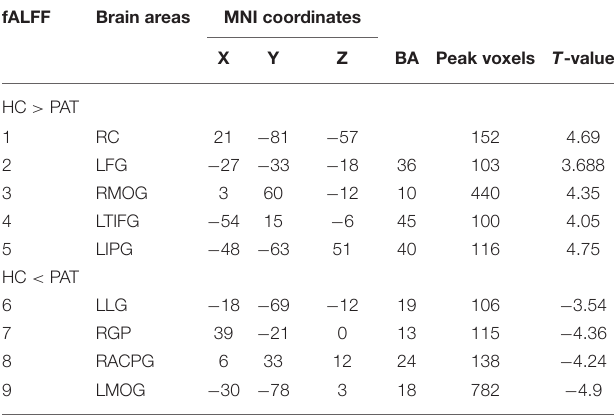
TABLE 2 | Brain regions with significant differences in fALFF between the HC and PAT groups.